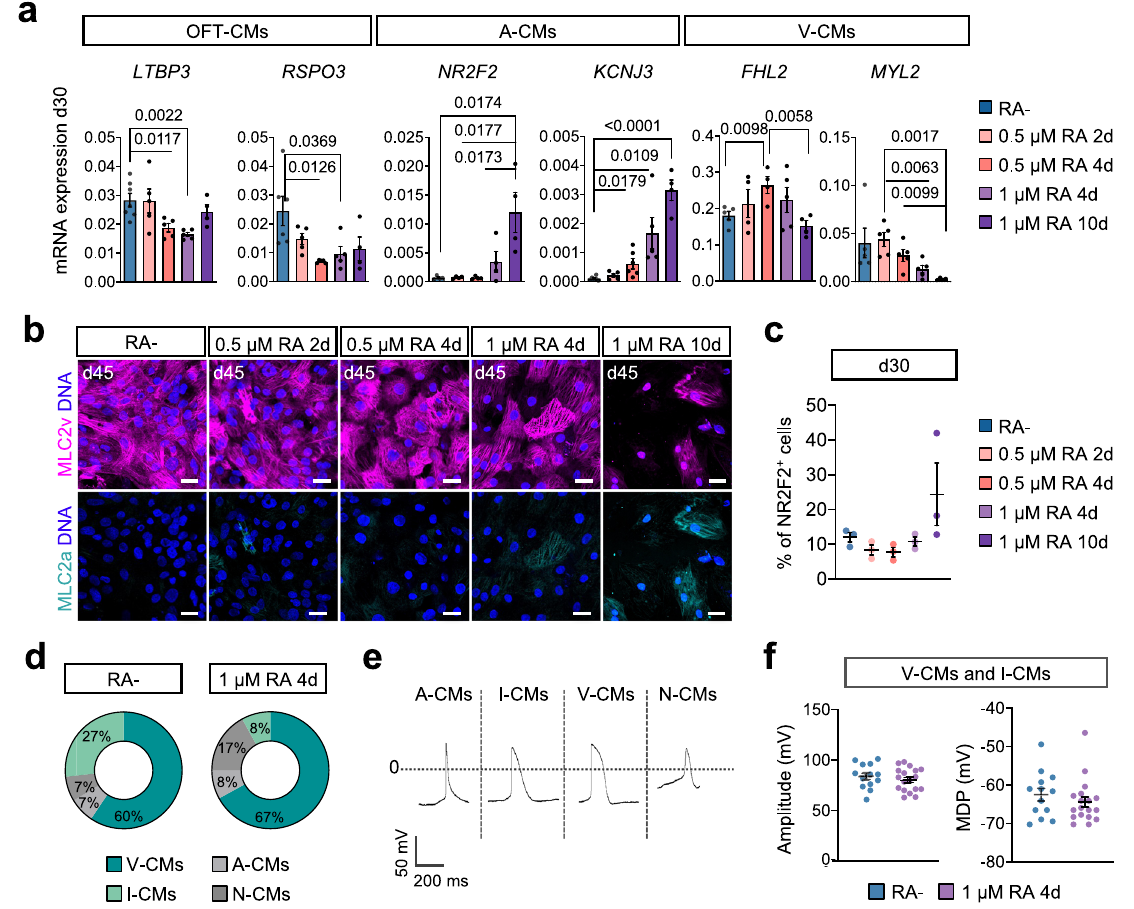
Fig. 2 | RA signaling modulation guides differentiation into distinct cardio- myocyte subtypes. a mRNA expression of markers of out fl ow tract CMs (OFT- CMs), atrial CMs (A-CMs) and ventricular CMs (V-CMs) relative to TNNT2 and GAPDH atday 30 of the indicated differentiation conditions. Data are mean±SEM. n =4 independent experiments except for: RA − LTBP3 n =7; MYL2 and FHL2 n =5; RSPO3 and KCNJ3 n =6; RA+ except for RA+ (1 µ M 10d) LTBP3 , RSPO3 , MYL2, KCNJ3 n =5; RA+ (1 µ M 4d) FHL2 n =5; RA+ (0.5 µ M 4d) n =6. Exact p -values of unpaired two-tailed t -test are shown. b Representative immuno fl uorescence images after staining for MLC2v (magenta) and MLC2a (turquoise) at day 45 of indicated dif- ferentiations conditions. Nuclei were counterstained with Hoechst-33258 (blue). Scale bar=25 µ m. c Percentage of cells stained positive for NR2F2 at day 30 of indicated differentiation conditions as determined by fl ow cytometry. Data are